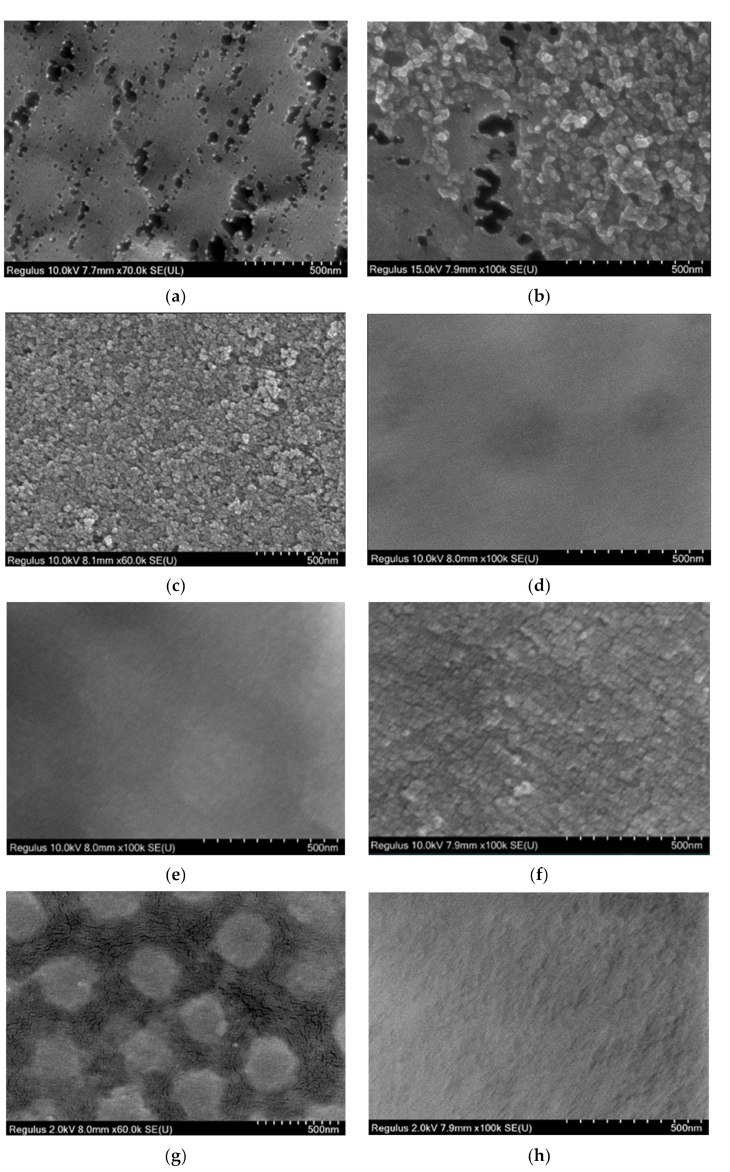
Figure 8. SEM images of the original A6 UF membrane ( a ), the same after deposition of trace amount of D500-PAAc polymer from water solution ( b ), A6 membrane completely covered with D20- PAAm polymer ( c ) and with D20-PAAc polymer ( d ), A6 membrane after deposition of D500-PAAc-U complexes under Approach 1 ( e ) and under Approach 2 (3 × deposition from water solution) ( f ); A6 membrane after deposition of D500-PAAm neutral polymer showing self-organization behavior and supramolecular structure responsible for the appearance of a structural color (Approach 1) ( g ), and A6 membrane with “roughened” surface due to formation of D500-PAAc-U complexes during uranium solution filtration (Approach 2) ( h